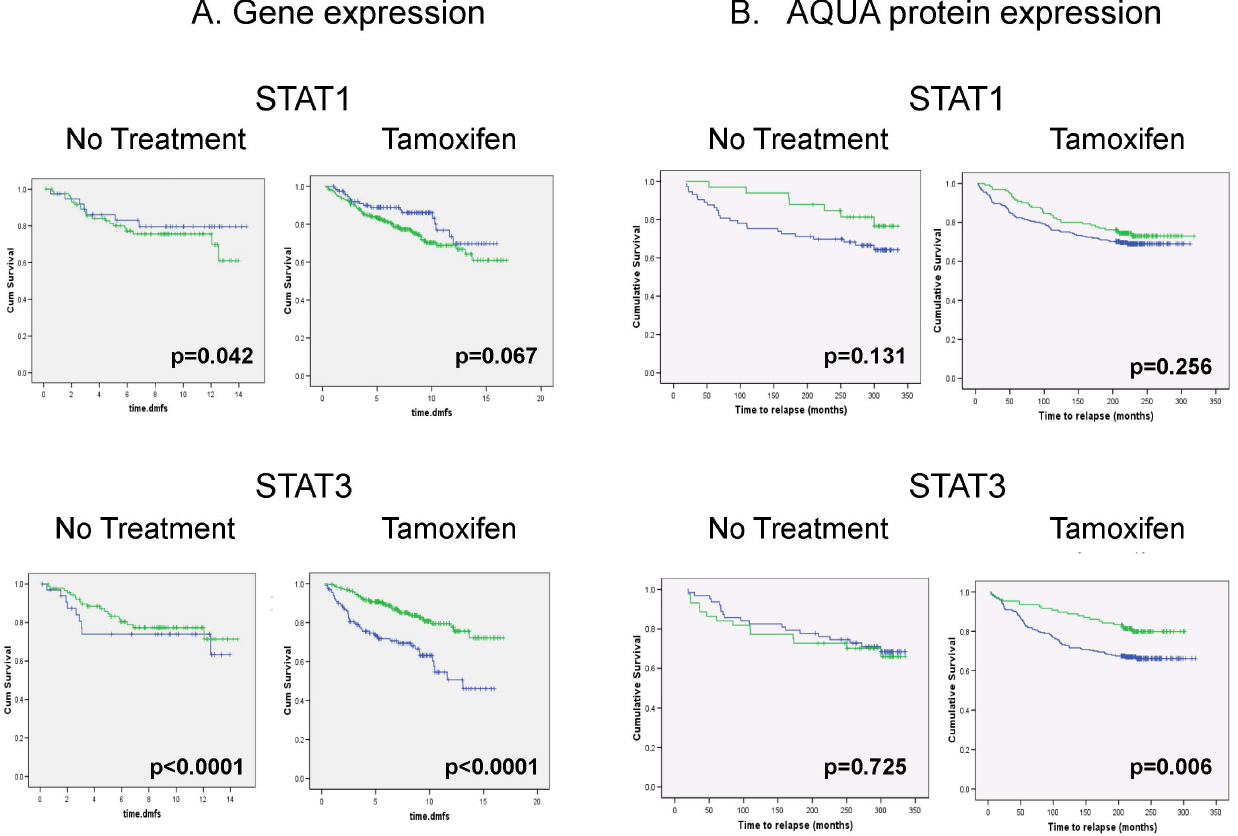
Figure 5. STAT expression and prognosis. Gene (A) and protein (B) expression of STAT1 and STAT3 in primary breast cancer (blue=low, green=high). Optimal cut-points were determined using the x-tile program while correcting for the use of minimum P statistics (31). Low STAT3 expression is associated with very poor outcomes for patients treated with tamoxifen (protein expression STAT3 high (78% fifteen-year survival) vs. STAT3 low (68% five year survival).